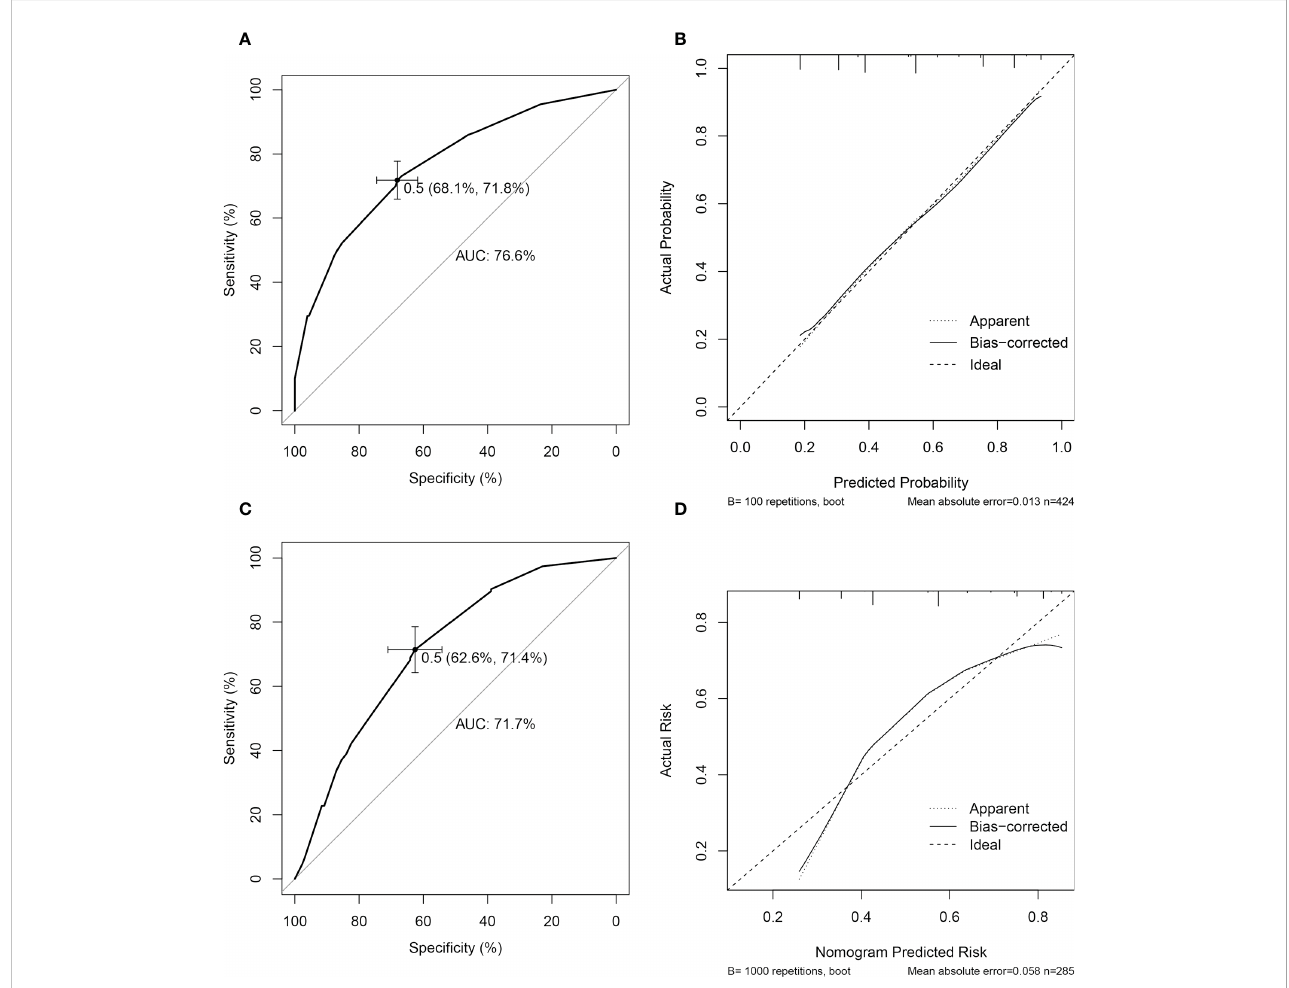
FIGURE 3 Performance of nomogram for predicting aggressiveness of papillary thyroid carcinoma. In the primary cohort, the performance of the predictive nomogram was evaluated by receiver operating curve analysis (A) and the calibration curve (B) . In validation cohort, the model was evaluated by the discrimination (C) and calibration (D)